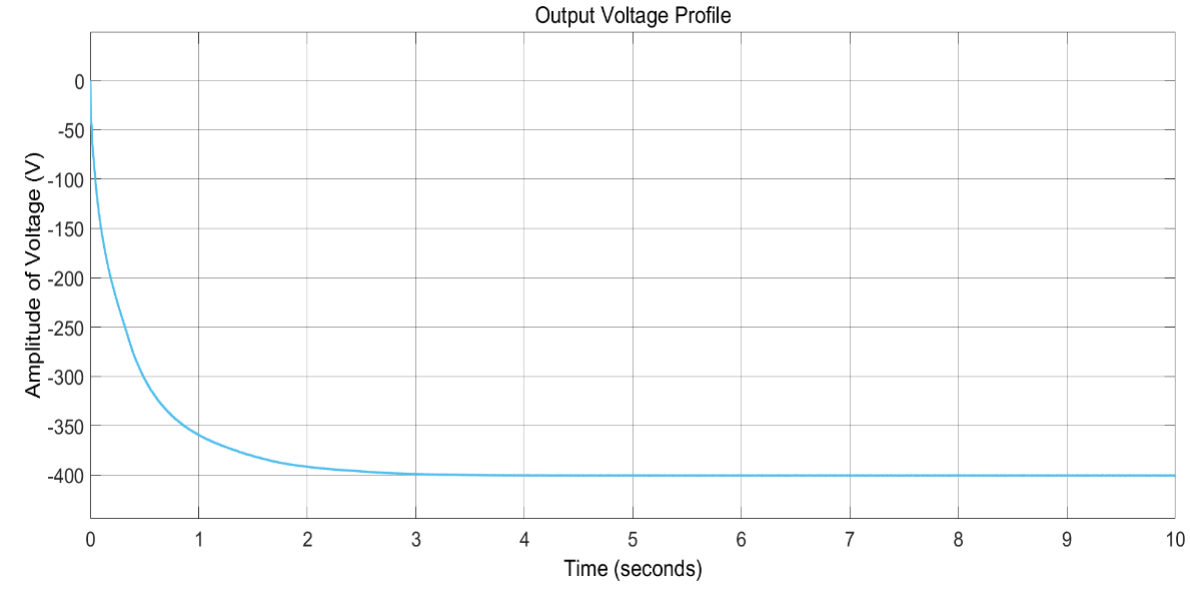
Figure 9. Output voltage profile.